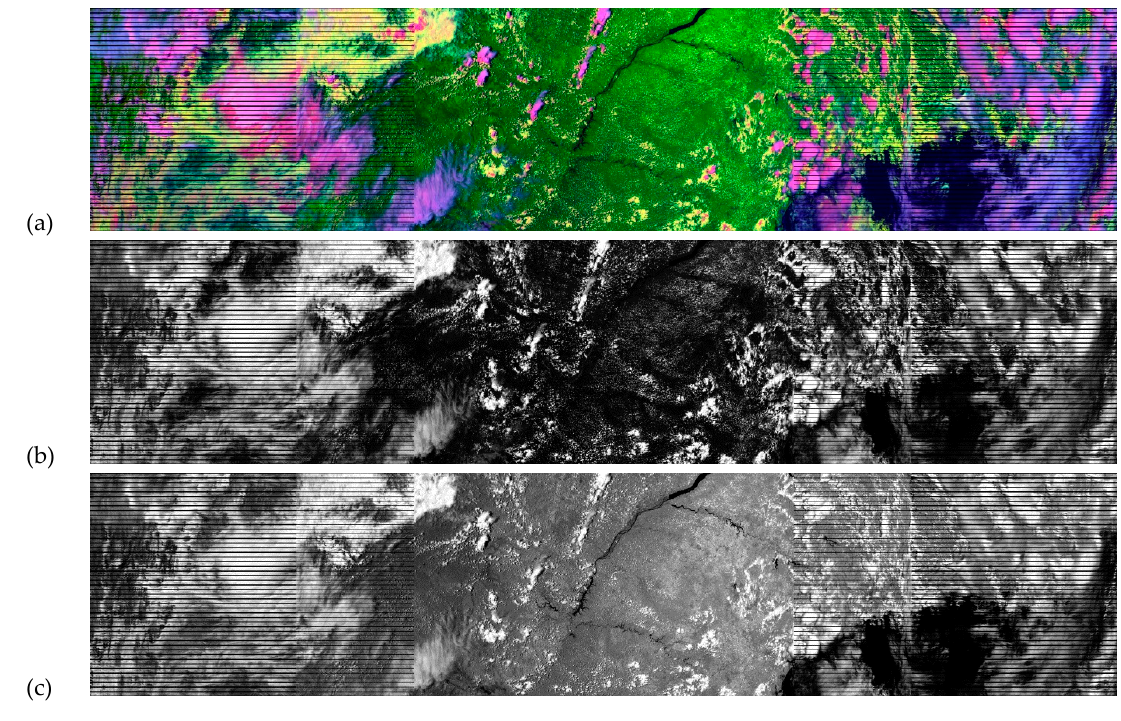
Figure 4. VIIRS imagery collected on 17 January 2013 at 1714 UTC over coastal Argentina and South America. ( a ) contains a false color composite from M5 (672 nm), M10 (1610 nm), and M16 (12,013 nm) in the RGB. ( b ) shows maximum cloud versus background contrast in the M5 while higher land reflectances in the M7 (865 nm) band, shown in ( c ), reduces the utility of this band for MGCNC analyses over vegetated land